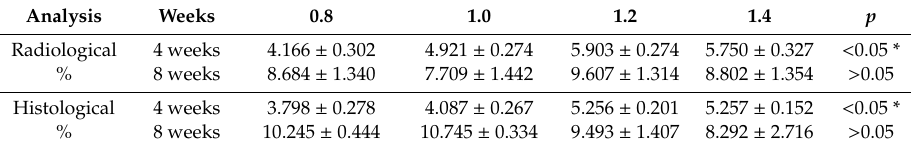
Table 1. New bone formation of 3D-printed HA / TCP sca ff olds with variable pore sizes.